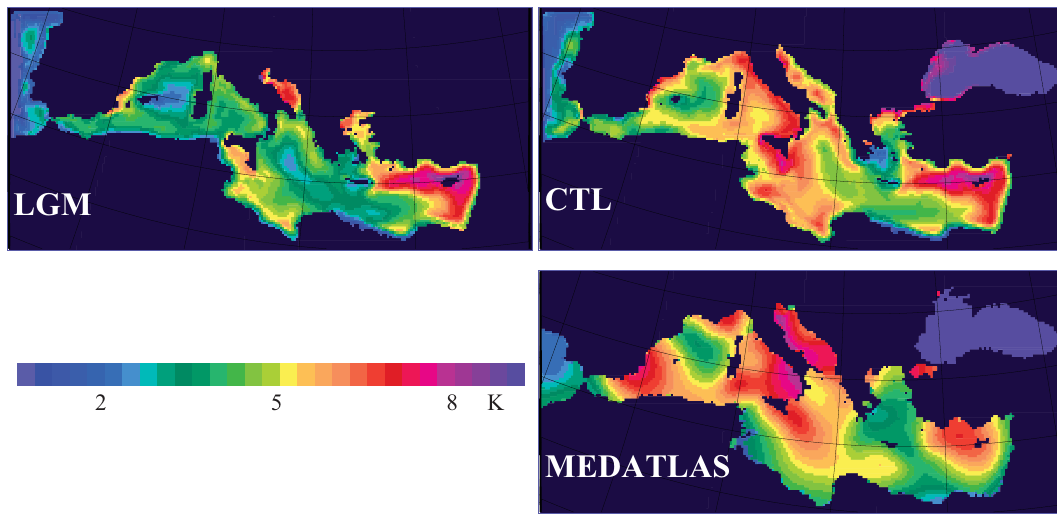
Fig. 8. Differences between summer (JAS) temperatures at 6 and 37m in K. LGM, CTL and observations (MEDATLAS).